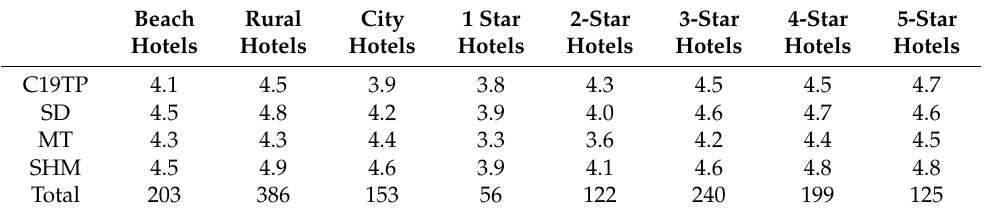
Table 11. Hotel manager’s perception depending on the types of